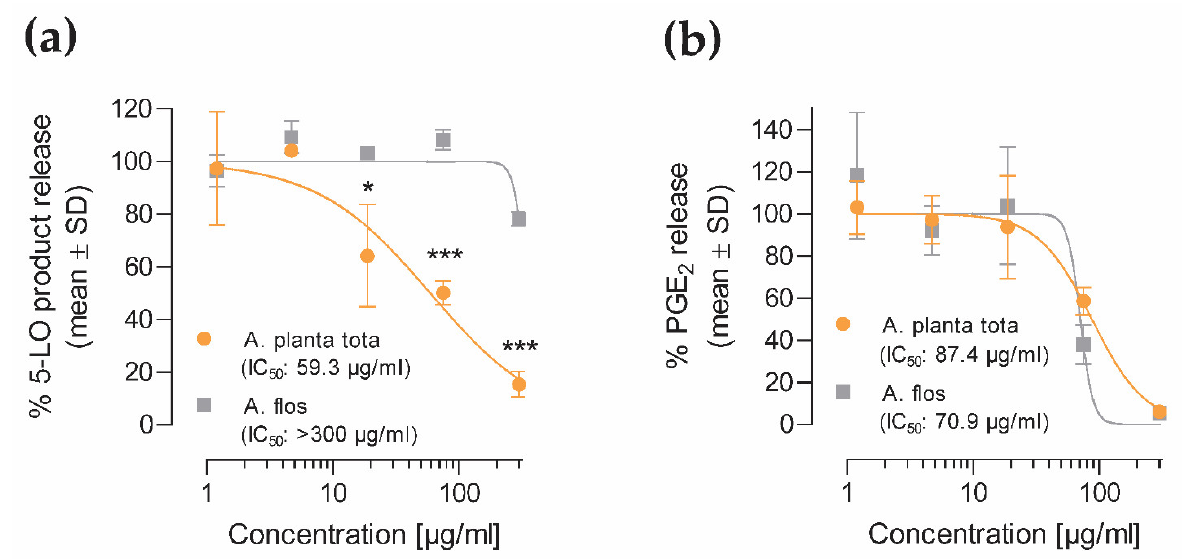
Figure 5. Inhibition of 5-LO ( a ) and COX-2 ( b ) product formation by Arnicae planta tota and Arnicae flos in isolated human peripheral blood cells. The inhibitory effect of Arnicae planta tota and Arnicae flos on 5-LO and COX-2 product formation was investigated in polymorphonuclear leukocytes (PMNL) ( a ) or in monocytes ( b ) isolated from peripheral blood of two ( a ) or three ( b ) healthy donors. Cells were pre-incubated with increasing concentrations of Arnicae planta tota and Arnicae flos for 15 min, then stimulated with either Ca 2+ -Ionophore A23187 in the presence of arachidonic acid for 10 min ( a ) or with LPS for 6 h ( b ). 5-LO product formation (sum of LTB 4 , its trans-isomers, and 5-HETE) was analysed using RP-HPLC ( a ) while COX-2 product formation (PGE 2 ) was measured using UPLC-MS/MS ( b ). Data (mean ± SD of two or three donors, separately), are expressed as the percentage of released products relative to vehicle control. Presented data are from one representative experiment out of two independent experiments. Differences in product release inhibition between Arnicae flos and Arnicae planta tota for each extract concentration was tested using a two-way ANOVA with Bonferroni’s correction for multiple comparisons (*, p < 0.05; ***, p < 0.001). Abbreviations: A. planta tota, Arnicae planta tota; A. flos, Arnicae flos; 5-LO, 5-lipoxygenase; PGE 2 , prostaglandin E 2 . Positive controls for 5-LO and COX-2 product release, and cytotoxicity controls are shown in Figure S5.